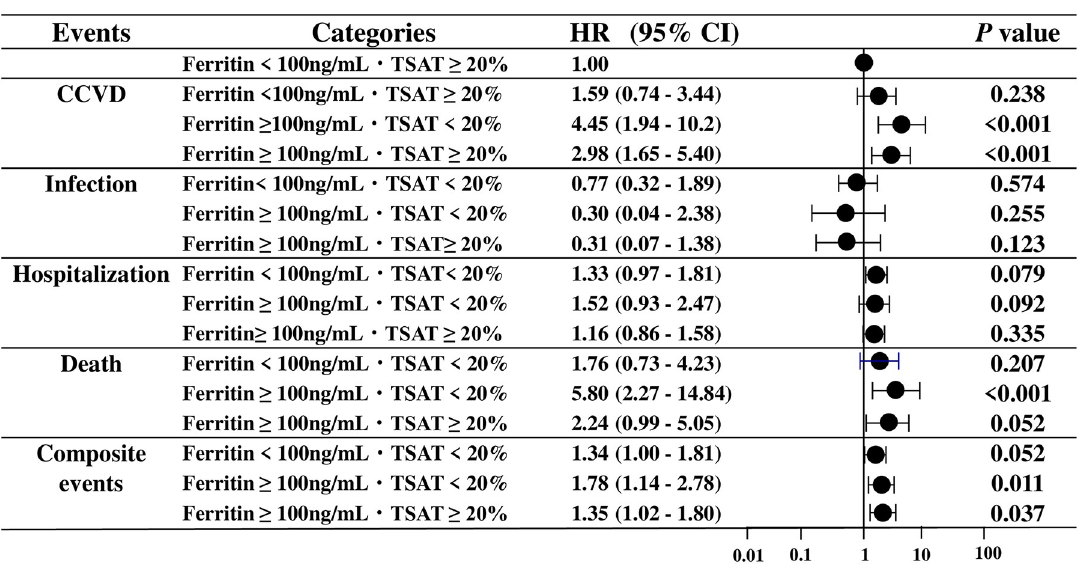
PLOS ONE | https://doi.org/10.1371/journal.pone.0236277 September 2,